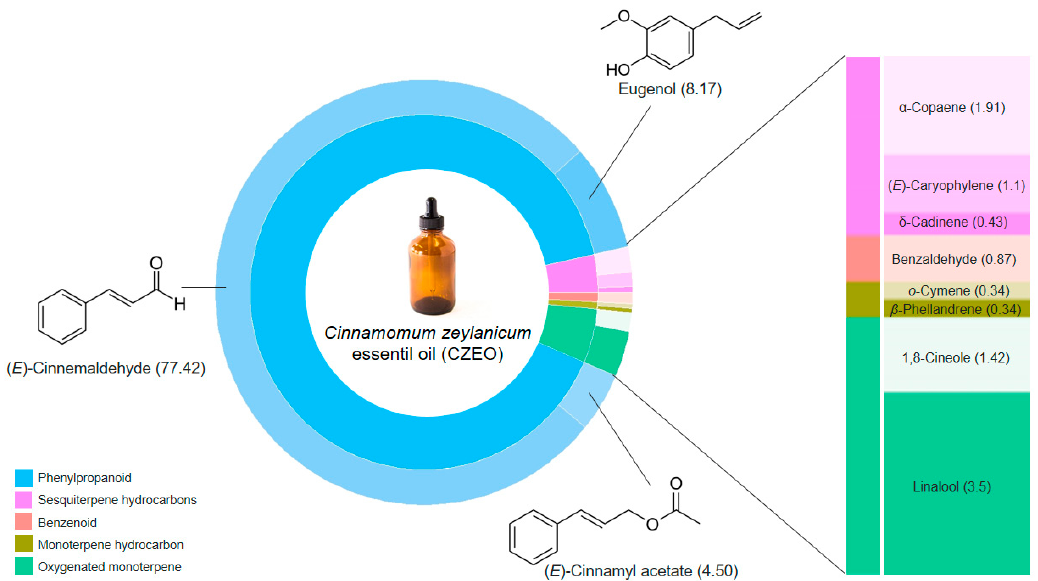
Figure 1. Percentage of the chemical compositions of the Cinnamomum zeylanicum essential oils (CZEO) and chemical structures of the main constituents.